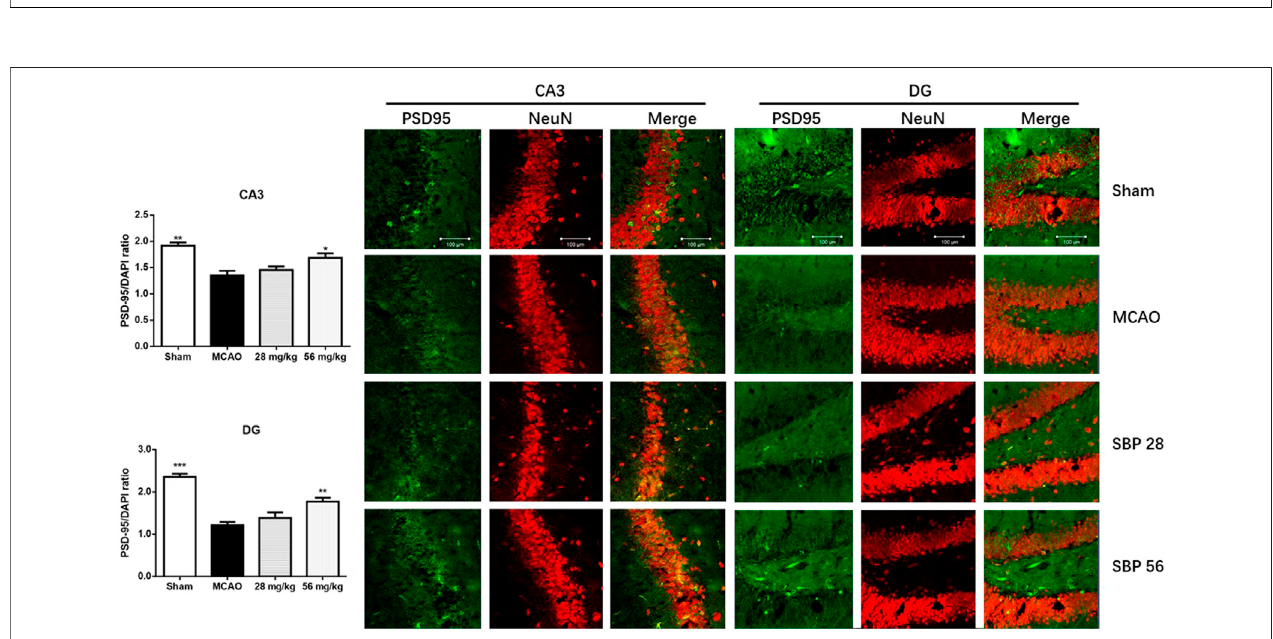
FIGURE 6 | Immuno fl uorescence images on PSD-95 (green) and NeuN (red) in the cornu ammonis 3 (CA3) and dentate gyrus (DG) of hippocampal subregions of rats at 14 days after MCAO (or sham surgery) operation. Data are expressed as mean ± SEM, n (cid:2) 3; * p < 0.05, ** p < 0.01, *** p < 0.001 compared to MCAO.